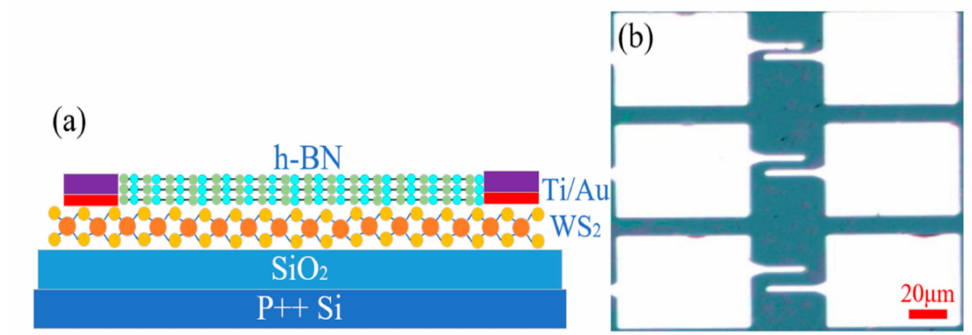
Figure 7. ( a ) Schematic diagram and ( b ) optical microscope image of FET array devices with WS 2 /h-BN vertical heterostructure